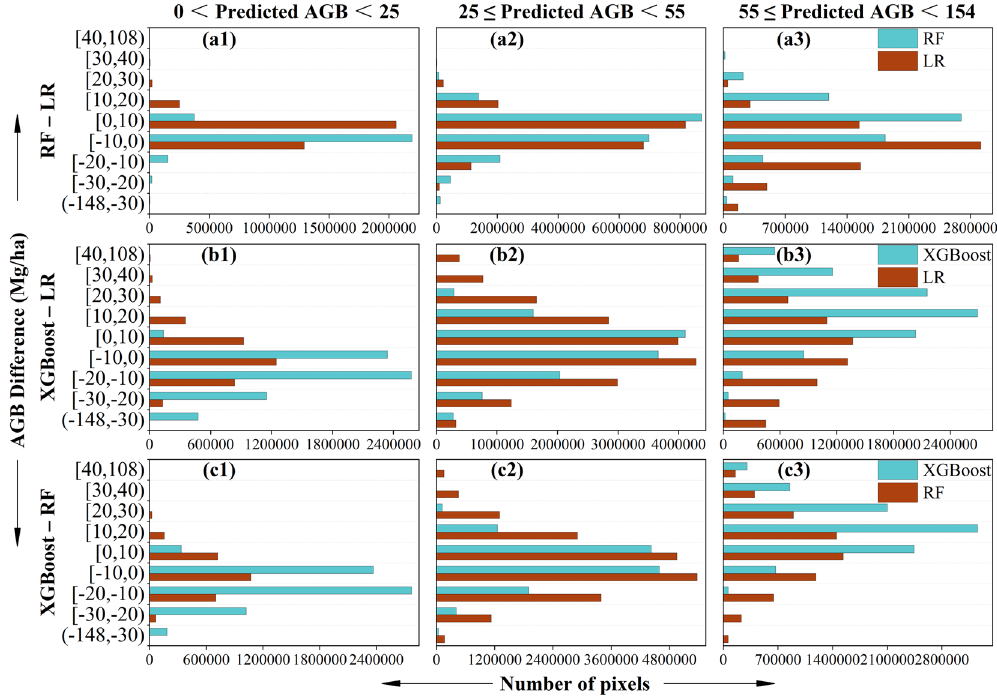
Figure 5. Histograms illustrating the difference of pixel numbers in three ranges. Note that the vertical axis labels represent the range of the prediction difference between XGBoost, RF, and